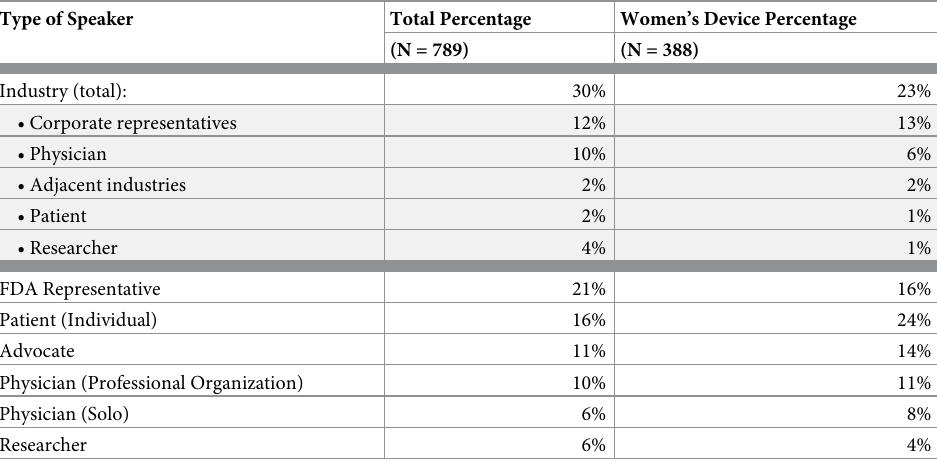
Table 2. Speakers for all device and women’s device meetings concerned with post-market safety.